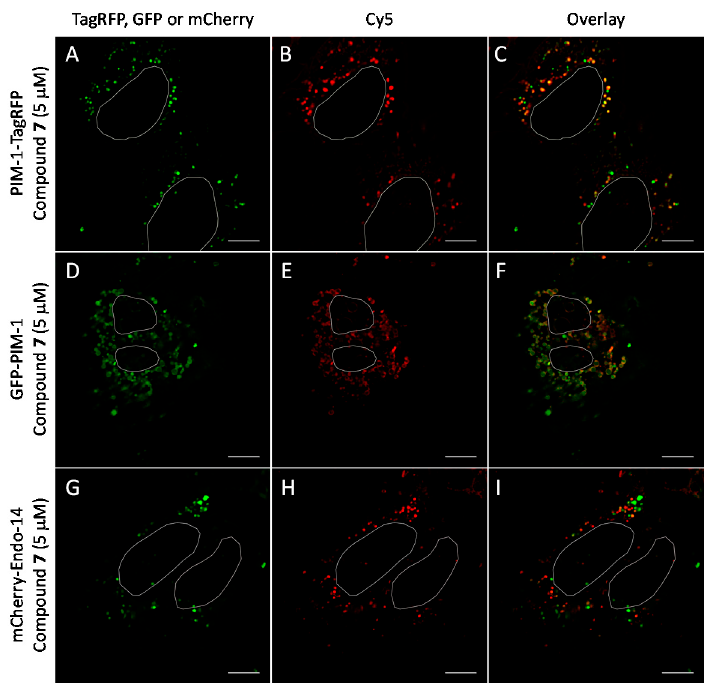
Figure 7. Co-localization studies of PIM-targeting compound 7 (5 µ M, 1 h incubation) with fluorescent protein-tagged PIM-1 and endosomal marker mCherry-Endo-14 in live U2OS cells. The genetically encoded PIM-1 constructs are shown in green and compound 7 is shown in red. Individual channels and overlaid images: ( A – C ) PIM-1-TagRFP and compound 7 ; ( D – F ) GFP-PIM-1 and compound 7 ; ( G – I ) mCherry-Endo-14 and compound 6 . Representative images (in cells with low expression of constructs) from two independent experiments are shown. White ovals indicate nuclei borders. Scale bar: 10 µ